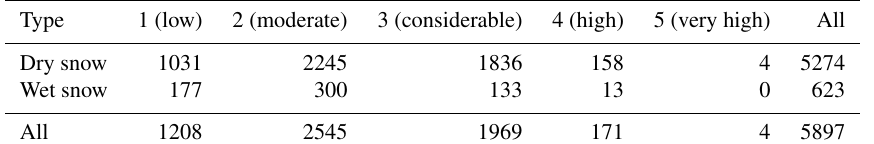
Table 3. Data overview: avalanche forecasts.